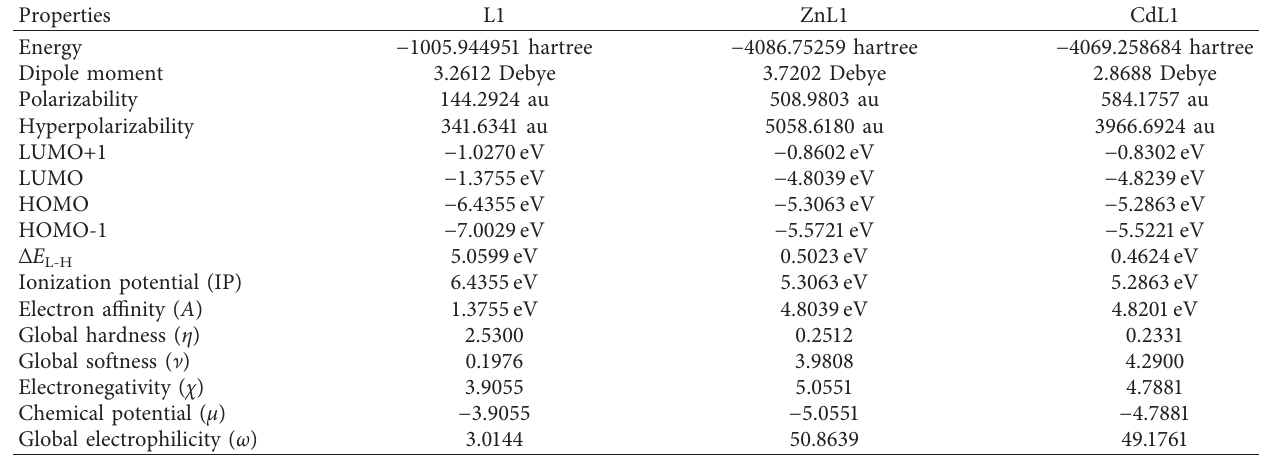
Table 3: Other electronic structure properties of L1, ZnL1, and CdL1.